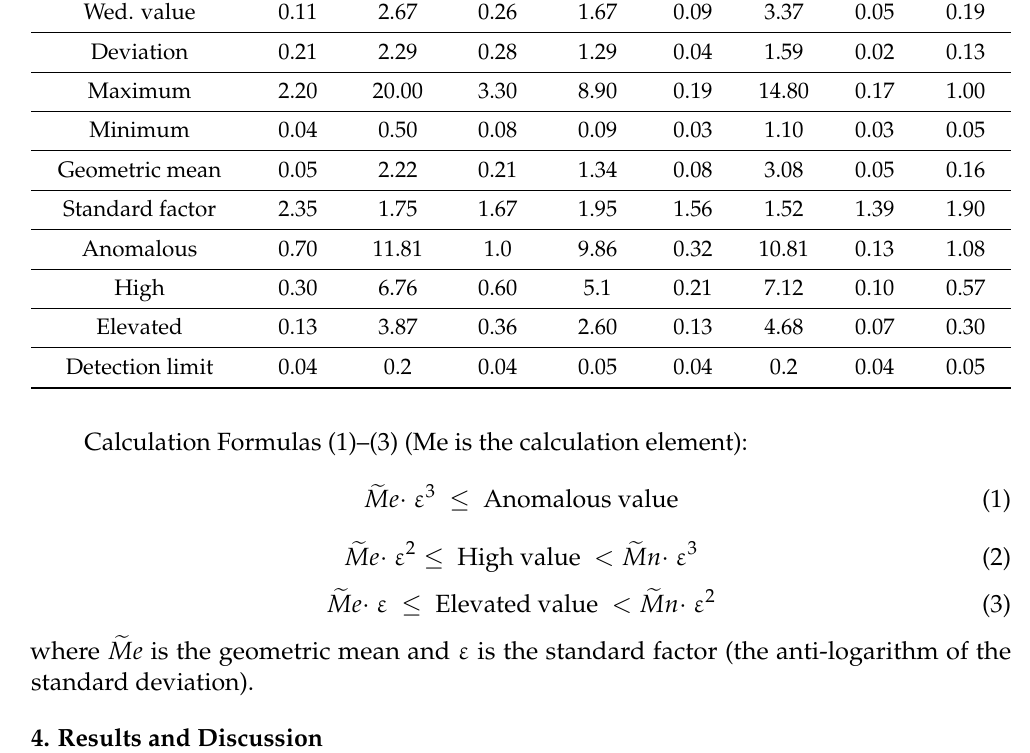
Table 2. Statistical characteristics of the concentrations of dissolved and suspended forms of trace elements in the search area ( µ g/L). Dissolved Form Solid Form